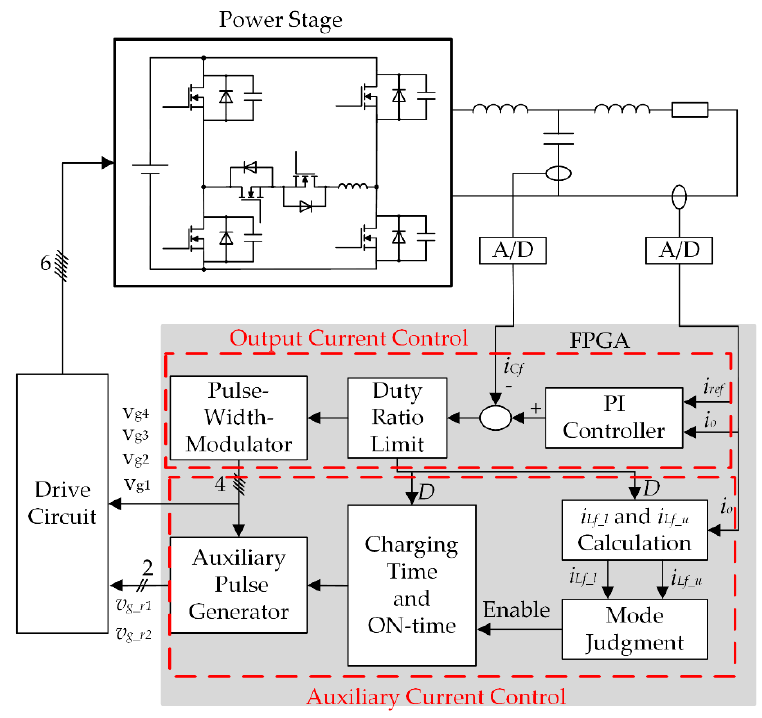
Figure 2. Control diagram of the ARSI.